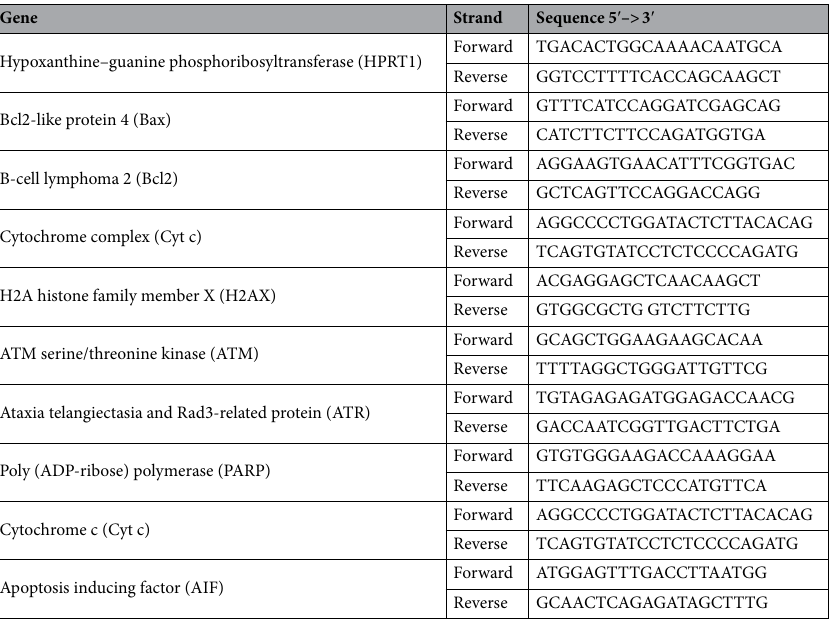
Table 2. Primer sequences used for